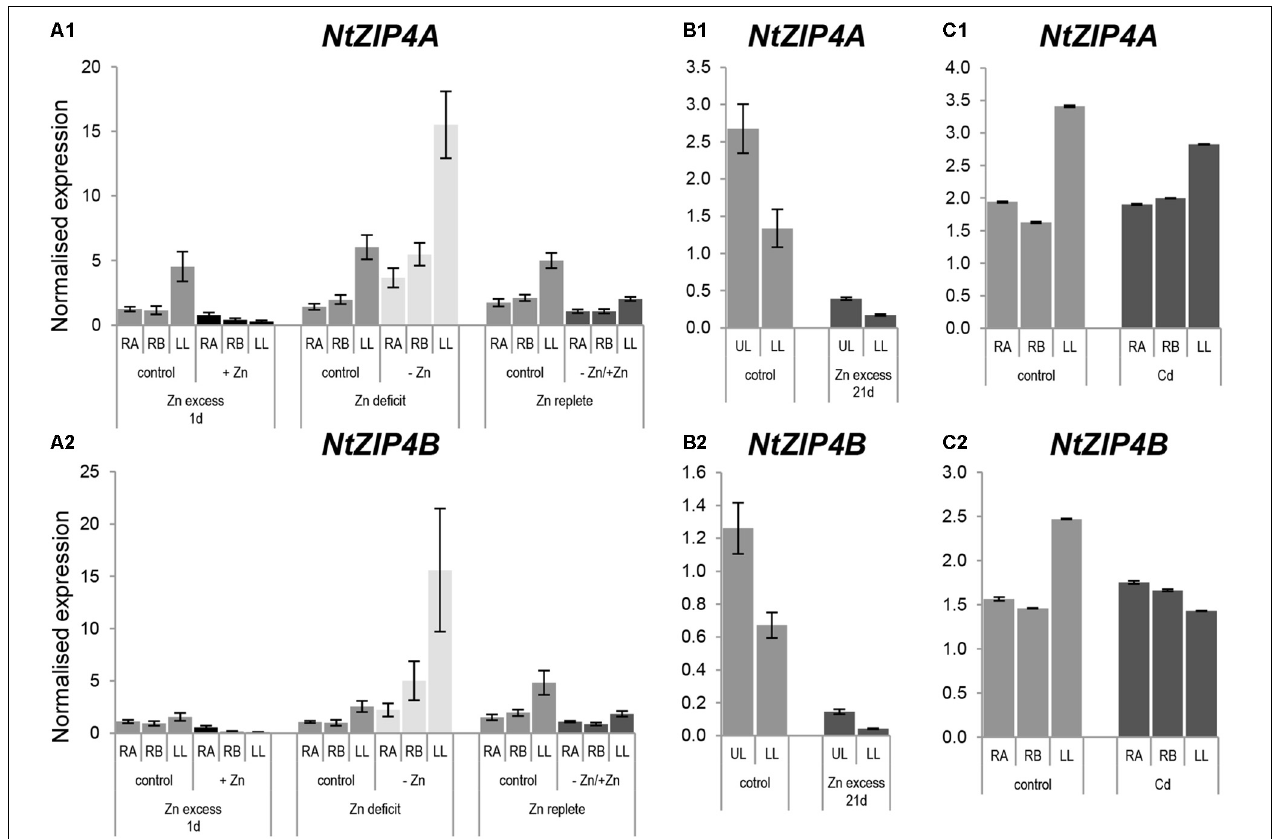
FIGURE 5 | Expression pattern of NtZIP4A and NtZIP4B in N. tabacum under various Zn conditions (A1,B1,A2,B2) and in the presence of Cd (C1,C2) . Plants were grown in the quarter-strength Knop’s medium (control) and then transferred to the control medium supplemented with the following Zn or Cd concentrations: (i) 50 µ M Zn for 1 day (Zn excess-1d); (ii) without Zn for 4 days (Zn deficit); (iii) plants grown at Zn-deficiency for 4 days were transferred to the control medium for 2 days (Zn replete); (iv) 50 µ M Zn for 21 days (Zn excess-21d); (v) 4 µ M Cd for 3 days (Cd). RT-qPCR analyses was performed on cDNA prepared from the two old lower leaves counting from the base (LL), two young upper leaves (UL), apical part of roots (RA), and basal part of roots (RB) of N. tabacum . Gene expression was normalized to the PP2A level. Values correspond to means ± SD ( n = 3); those with the ratio greater than two are considered significantly